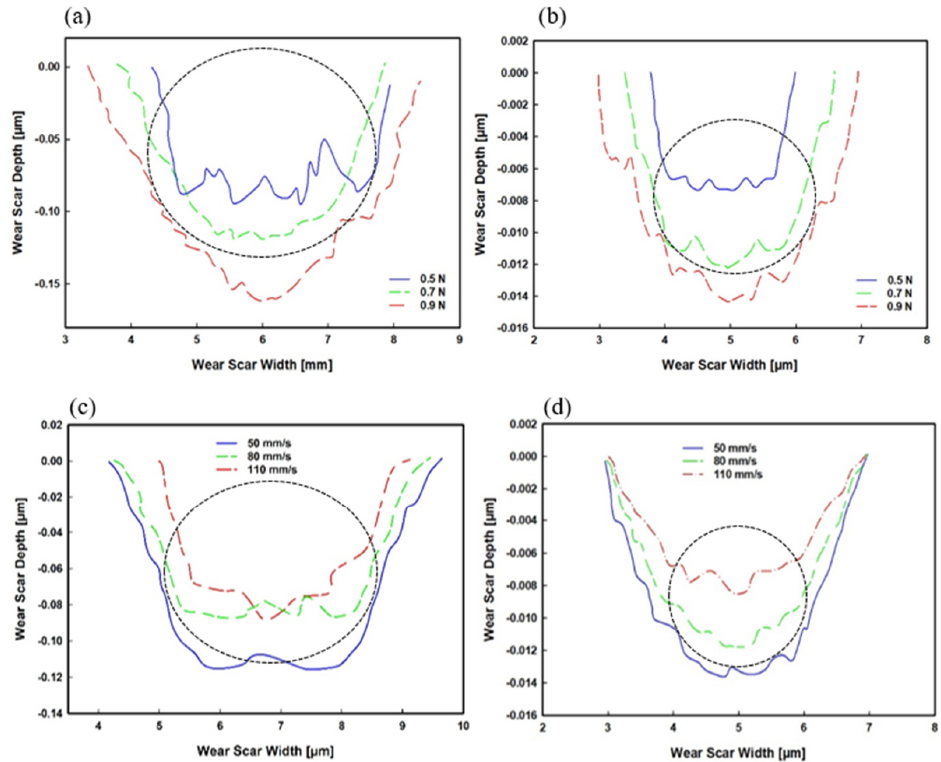
Figure 7. Wear scar depth and width for different applied normal loads under a constant sliding speed of 80 mm/s for ( a ) NRHs, ( b ) NCHs samples; and at different sliding speeds under a constant load of 0.7 N for ( c ) NRHs, ( d ) NCHs samples.